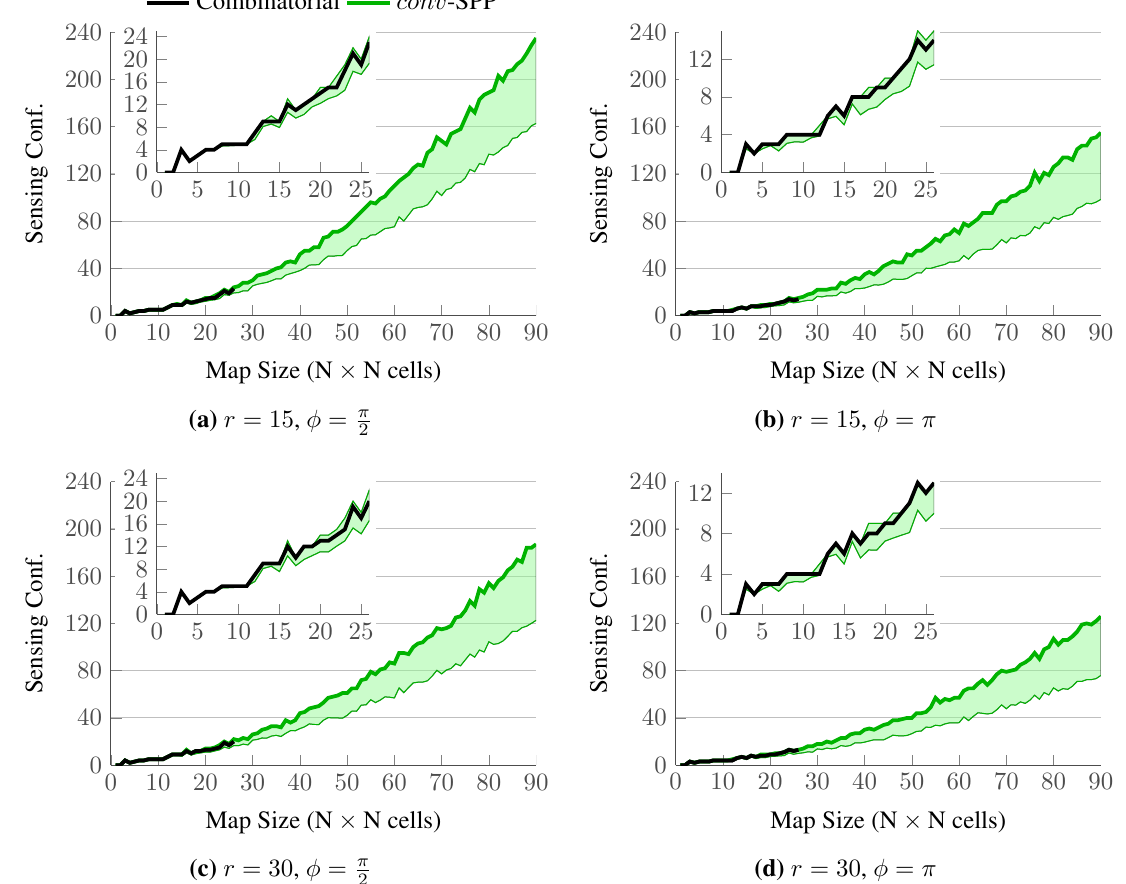
Figure 11. Comparison of the quality of the solutions obtained with conv -SPP and the combinatorial method on randomly generated maps. Sensing parameters are fixed to Θ = { 0 , π , π, 3 π } , r = { 15 , 30 } , and φ = { π, π/ 2 } . The optimal solutions (thick black 2 2 lines) are close to the solutions provided by conv -SPP (thick green lines) with respect to the number of sensing configurations selected. The lower bounds of the green intervals represent the result of a single (cid:96) -minimization 1